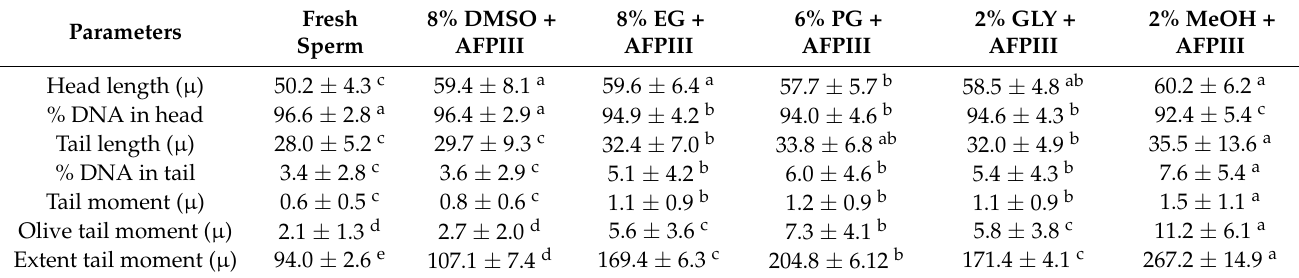
Table 1. Comet assay parameters (mean ± standard deviation) for fresh and cryopreserved sperm of H. discus hannai . Parameters